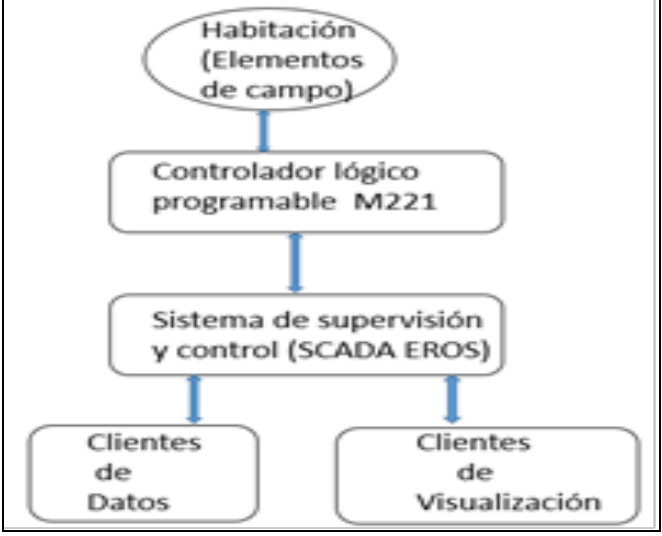
Figura 5: Partes del sistema SCADA. Fuente: Los autores,